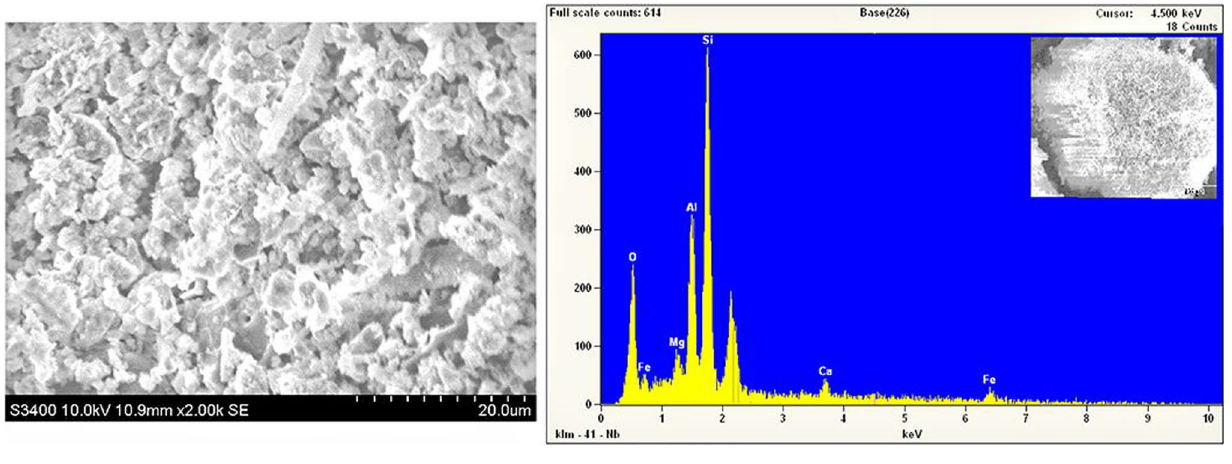
Fig. 1 SEM–EDS of water treatment residuals